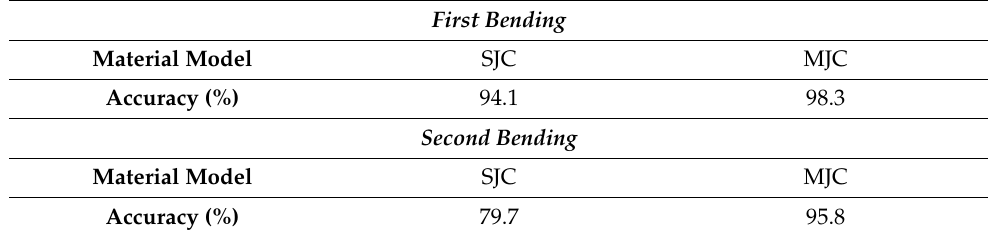
Figure 11. Comparison of the force-deflection curve between the MJC and SJC at the ( a ) 1st bending and ( b ) 2nd bending. The deviations between calculated and experimentally measured forces for one half cycle are shown in Table 2. Table 2. Accuracy of the material models for one half cycle.